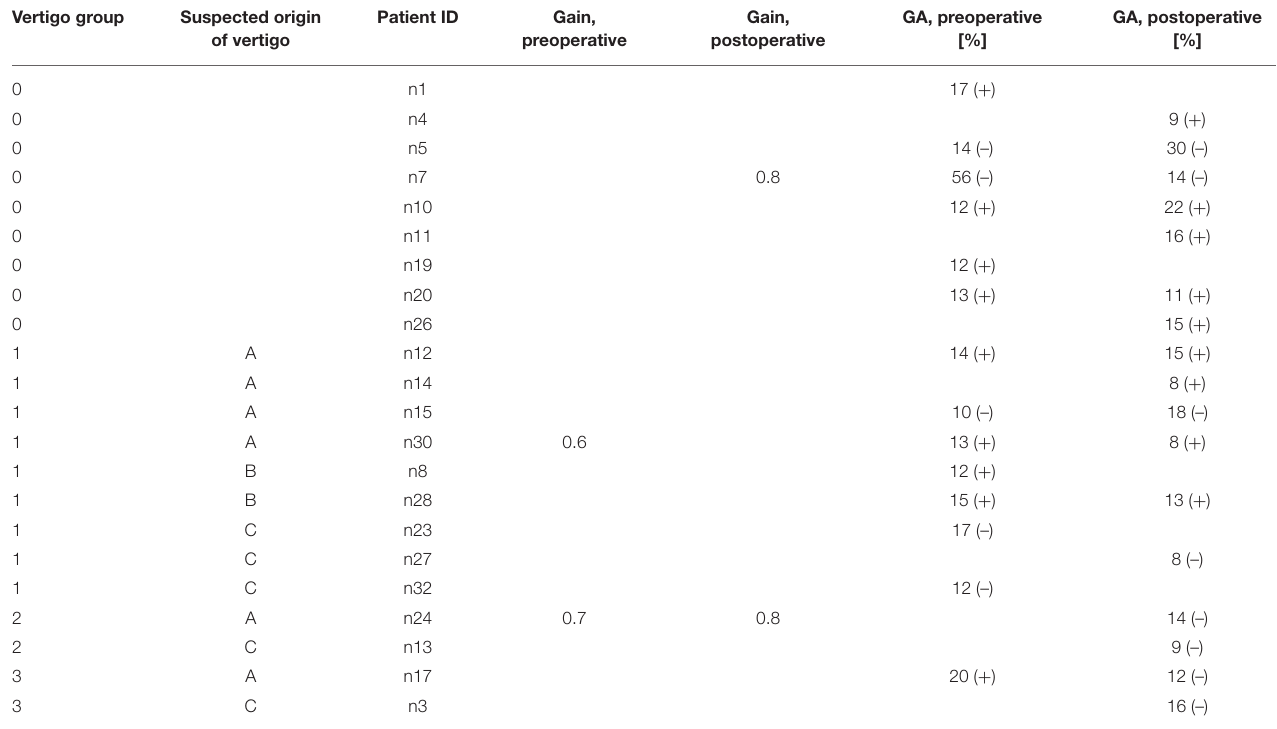
TABLE 5 | vHIT test, conspicuous results only (for information on vertigo group and origin of vertigo, see Table 2 ). Vertigo group Suspected origin Patient ID Gain, of vertigo